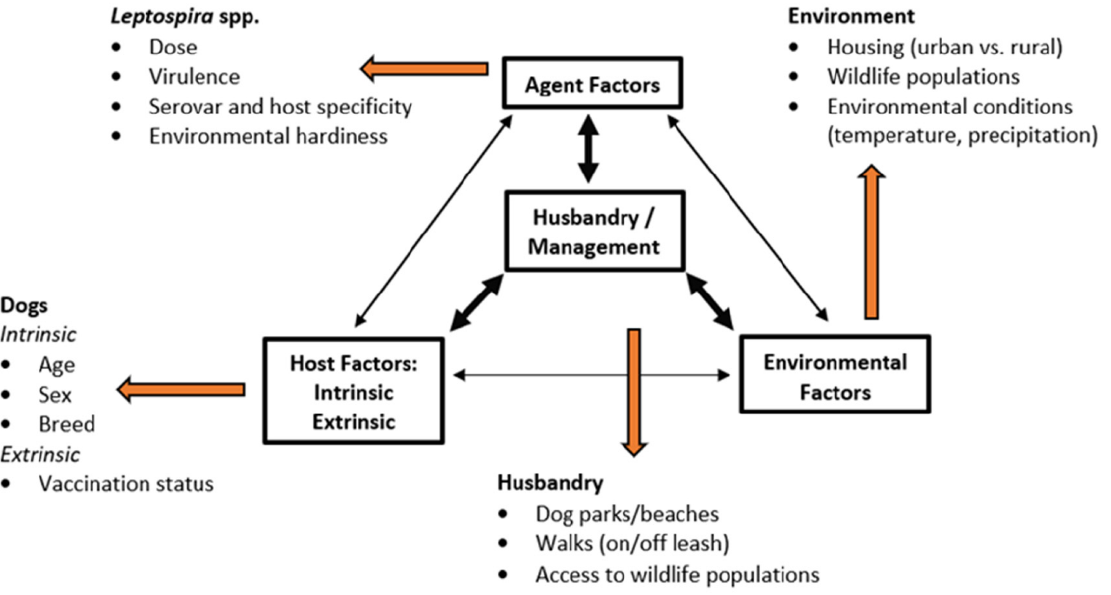
Figure 1. An epidemiologic triad of canine leptospirosis.